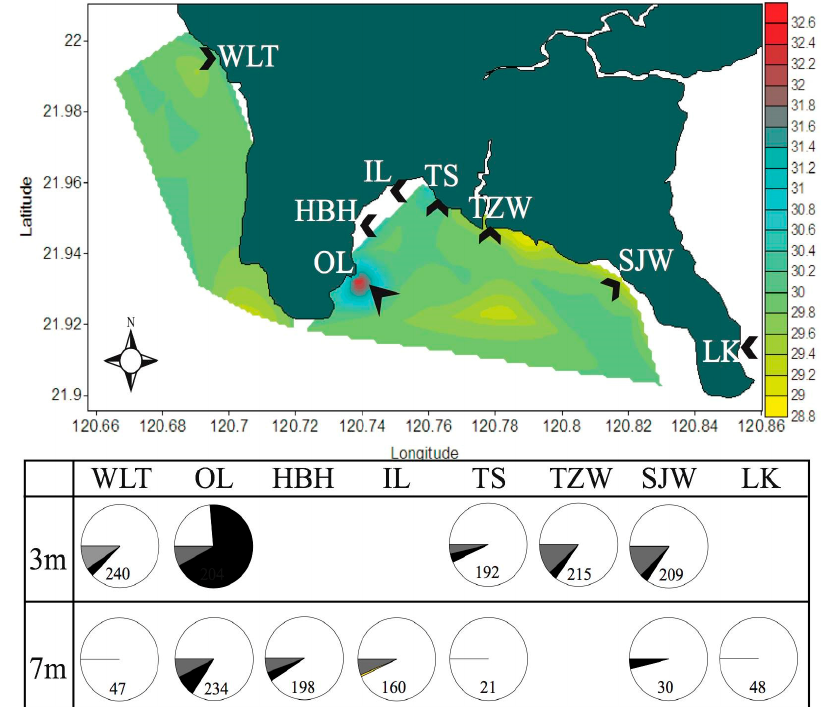
Figure 8. Symbiont diversity associated with corals at different locations—Wanlitung (WLT), NPP outlet (OL), Houbihu (HBH), NPP Inlet (IL), Taioshi (TS), Tanziwan (TZW), Siangjiaowan (SJW), and Longkeng (LK)—and from the reef near the nuclear power plant outlet (OL) in Kenting National Park. Samples were collected in 2009 and 2010 from 3 m and 7 m depths. Pie-Charts were drawn using data from previous publications (Keshavmurthy, S. etc. 2014). Analysis of samples collected was done using srDNA-RFLP, ITS2-DGGE and ITS1-qPCR (see Table 4). White = Cladocopium sp. (previously clade C), Black = Durusdinium sp. (previously clade D), and Grey = co-occurrence of Cladocopium sp. and Durusdinium sp. The values inside the pie-charts are total sample numbers for each location.